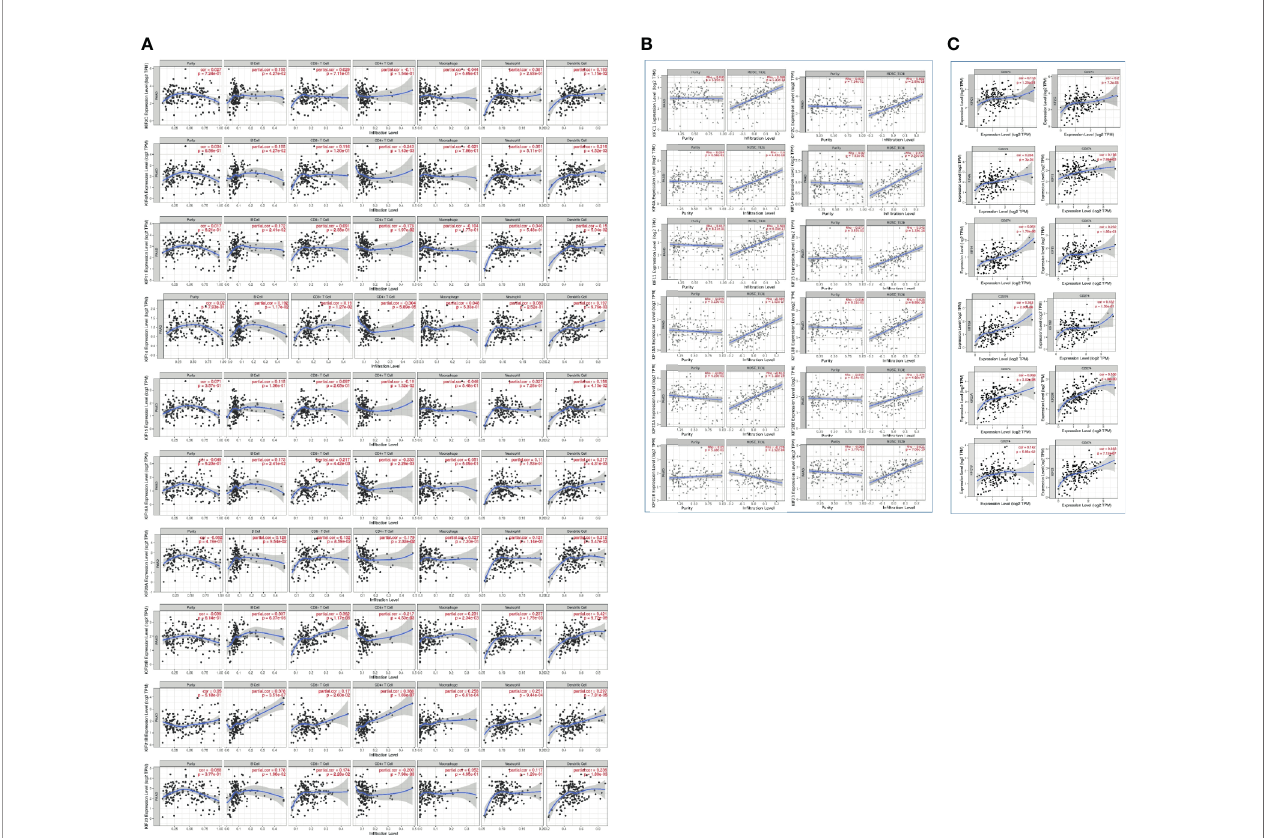
FIGURE 7 | Correlation between prognosis-related KIFs expression and immune in fi ltration in PDAC patients (TIMER). (A) The correlation of 6 immunocytes with prognosis-related KIFs was estimated. (B) The correlation between MDSCs in fi ltration and prognosis-related KIFs. (C) The correlation between CD274 and prognosis-related KIFs. Cor > 0 represents a positive correlation, Cor < 0 represents a negative correlation. P < 0.05 means a signi fi cant